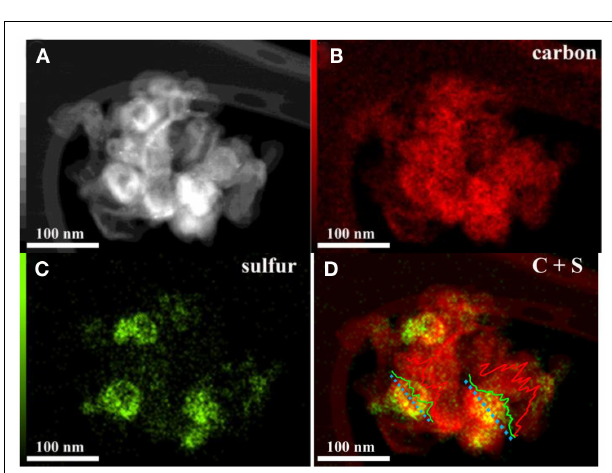
FIGURE 3 | (A) HAADF Z-contrast image; (B) carbon and (C) sulfur EDX maps; (D) overlaid C/S map of HCNS/S50 composite material. Inset in (D) are the intensity profiles of carbon and sulfur across the HCNS/S composite nano particles.